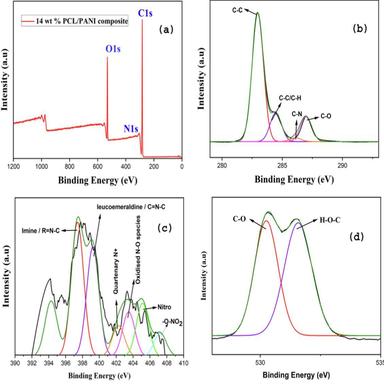
XPS spectra of 14 wt% PCL/PANI composite (a) XPS survey scan of 14 wt% PCL/PANI composite (b) C 1 s region (c) N 1 s region (d) O 1 s region of the sample.